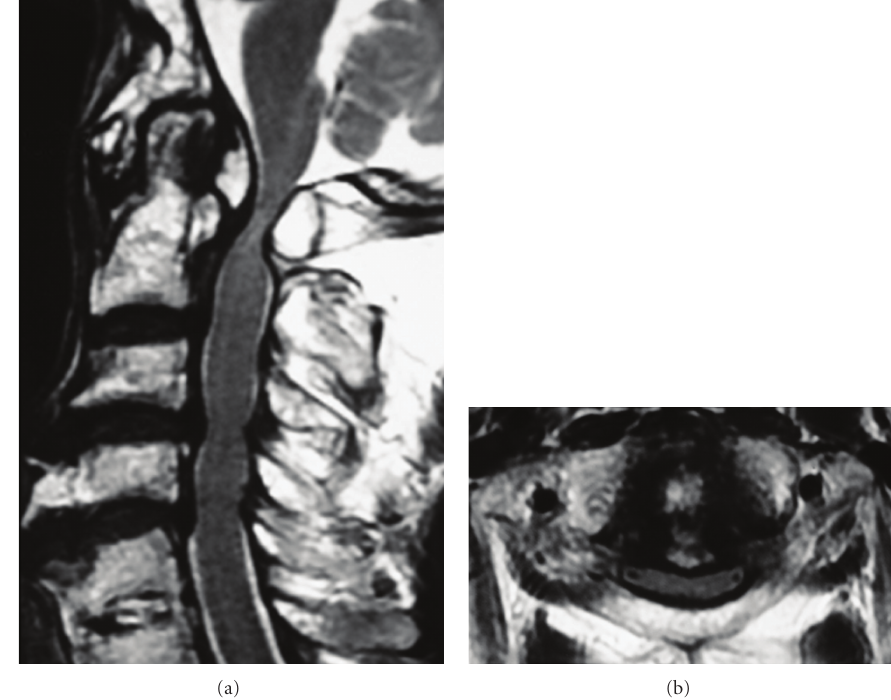
Figure 3: Preoperative MRI on T2-weighted image. (a) Sagittal plane. The spinal cord is compressed at the level of C1, C3-4, and C4-5, with high intensities within the spinal cord at C1 level. (b) Axial plane. The spinal cord is compressed by the mass behind dens and posterior arch of the atlas.